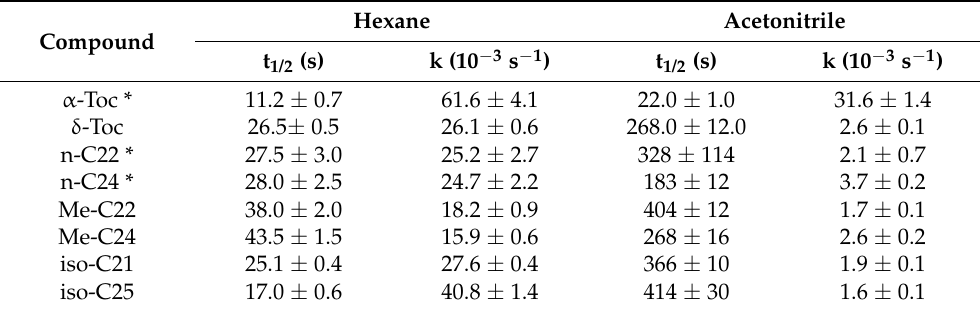
Table 4. Half-times of the reaction and pseudo-first-order reaction rate constants k for the reaction of N -acylserotonins and tocopherols with DPPH in solvents of different polarity. The data are means ± SE ( n =